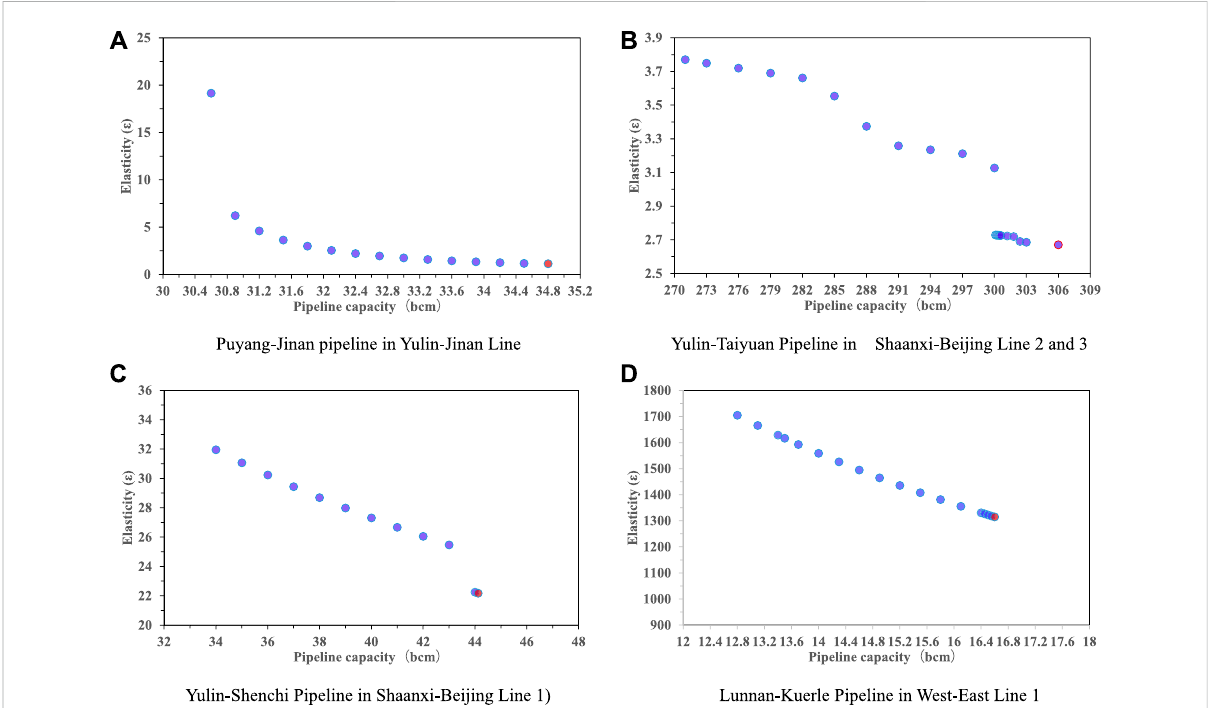
FIGURE 7 The heterogeneous elasticity of capacity-cost in China ’ s exiting gas network (A) Puyang-Jinan pipeline in Yulin-Jinan Line (B) Yulin-Taiyuan Pipeline in Shaanxi-Beijing Line 2 and 3 (C) Yulin-Shenchi Pipeline in Shaanxi-Beijing Line 1) (D) Lunnan-Kuerle Pipeline in West-East Line